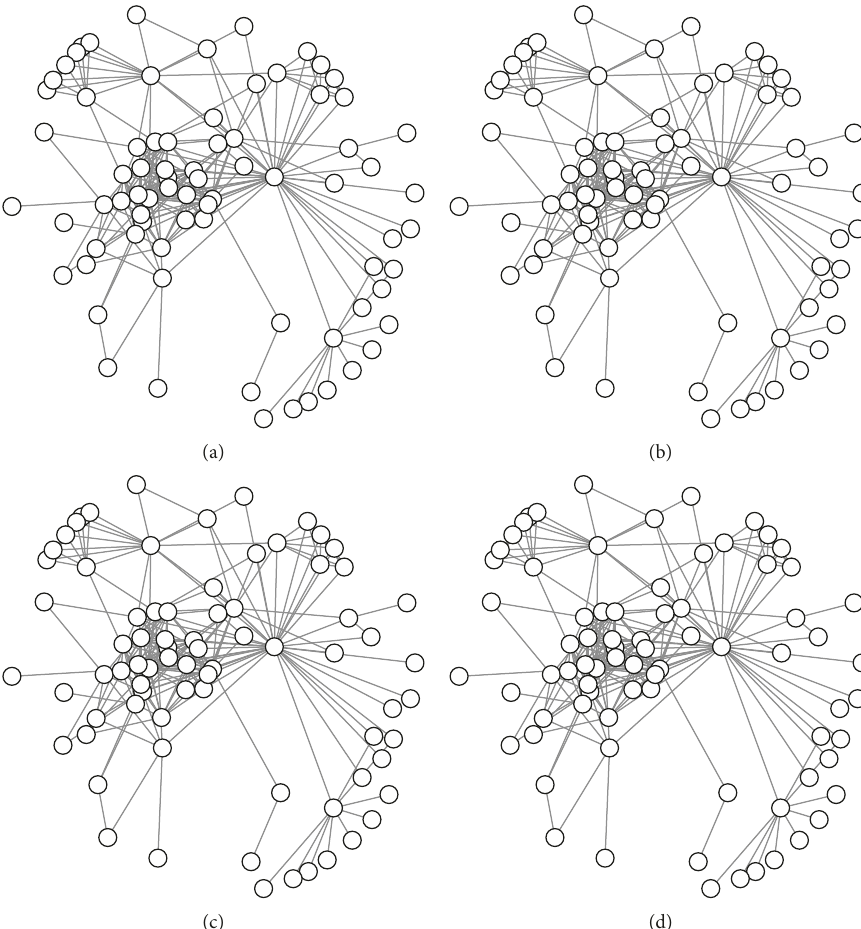
Figure 7: Different link scoring techniques applied to the Les Miserables coappearance network [58]: common neighbors (a); preferential attachment score (b); Sorensen score (c); Katz index (d). Link width in the figure is proportional to the link score. Table 3: Computational time complexity and bibliographic references for the link scoring and prediction methods provided by NOESIS.